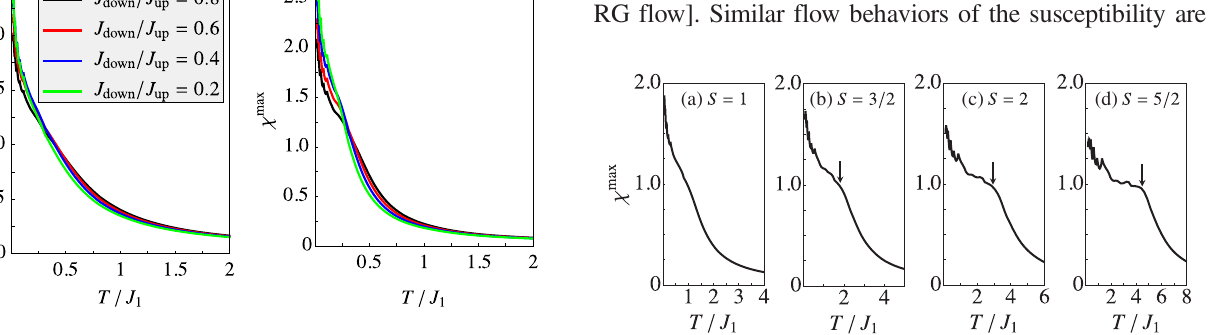
FIG. 11. The RG flow of the susceptibility tracked at the dominant wave vector for different values of the breathing anisotropy for (a) S ¼ 1 = 2 and (b) S ¼ 1 nearest-neighbor Heisenberg antiferromagnet.